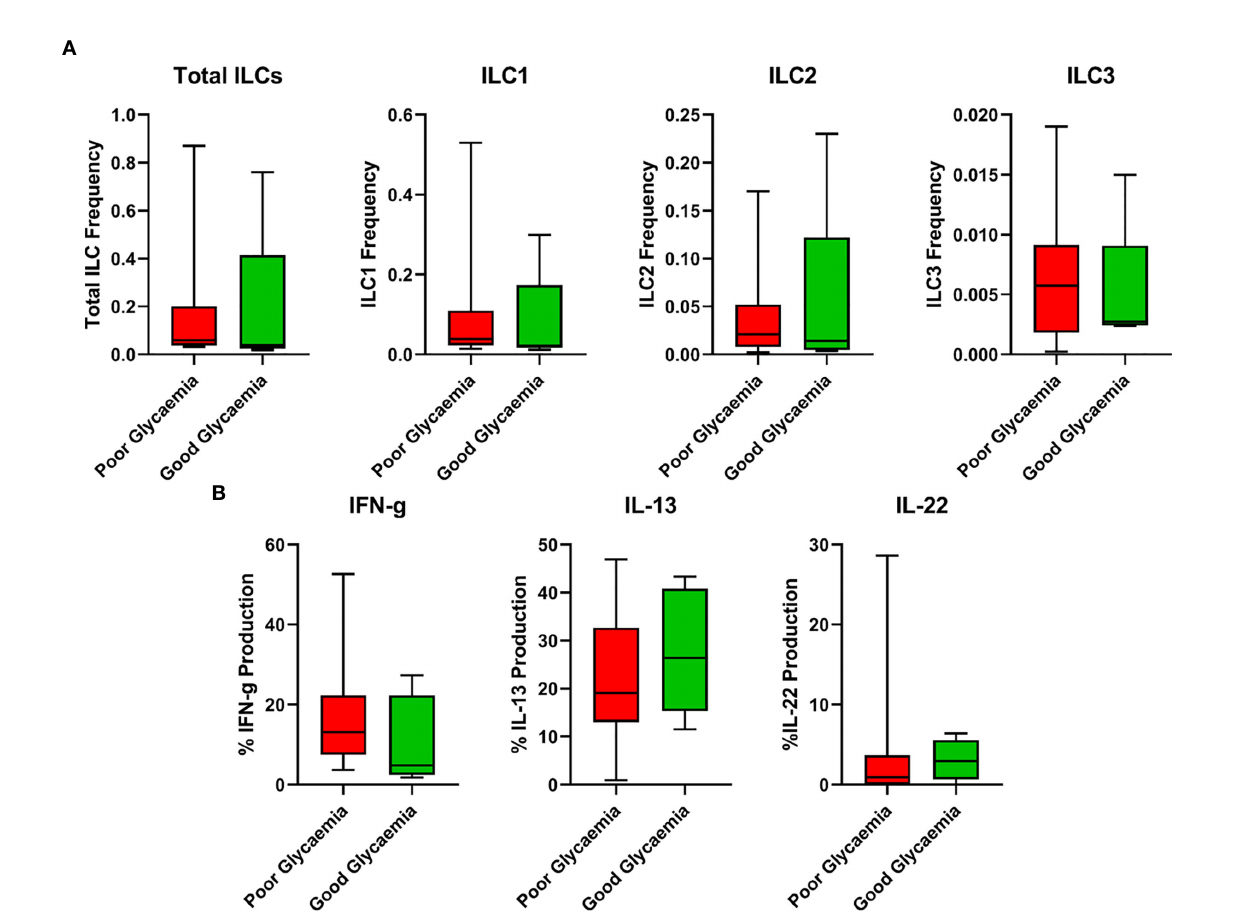
FIGURE 4 | Relationship between ILC responses and diabetes control (Poor and good glycaemic control). (A) Responses of total ILCs, ILC1, ILC2, ILC3 in poor and good glycaemic control. (B) Responses of IFN- g , IL-13 and IL-22 in poor and good glycaemic control. Box plots show median values and 25th – 75th percentiles from data in each group with maximum and minimum values. Poor glycaemic control was de fi ned as HbA1c levels ≥ 7.0%, and good glycaemic control was de fi ned as HbA1c levels < 7%. The non-parametric Mann-Whitney U test was performed, and differences were considered statistically signi fi cant at P < 0.05 and 95% con fi dence level. Non-signi fi cant P-values were not shown. Size of groups: LTBI and T2DM (n = 13), LTBI (n = 14), T2DM (N=10), and HC (n =